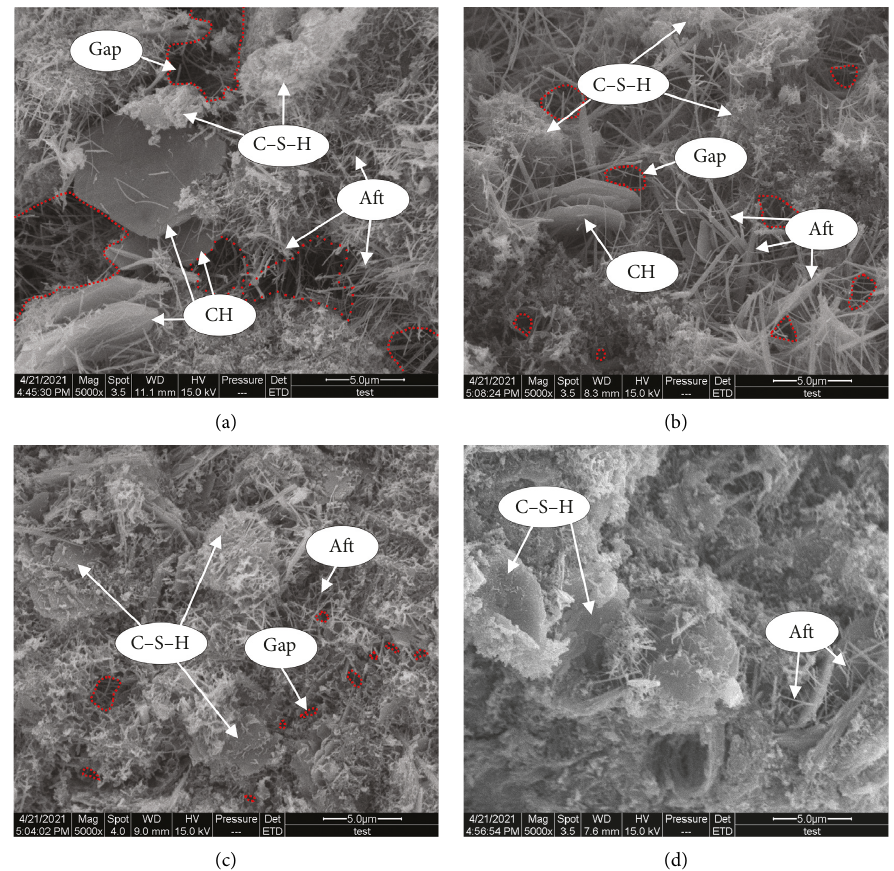
Figure 15: SEM photos of the hydration products of the optimum mix ratio of filling material at different curing ages. (a) 1d curing age. (b) 3d curing age. (c) 7d curing age. (d) 28d curing